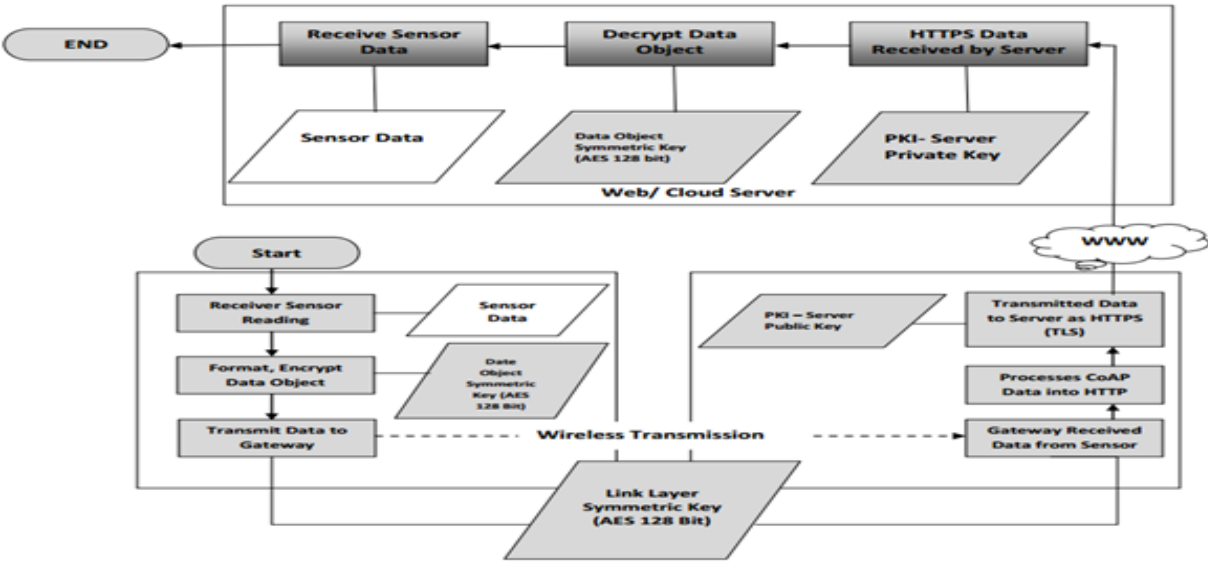
Figure 4. Device to Server, Solution